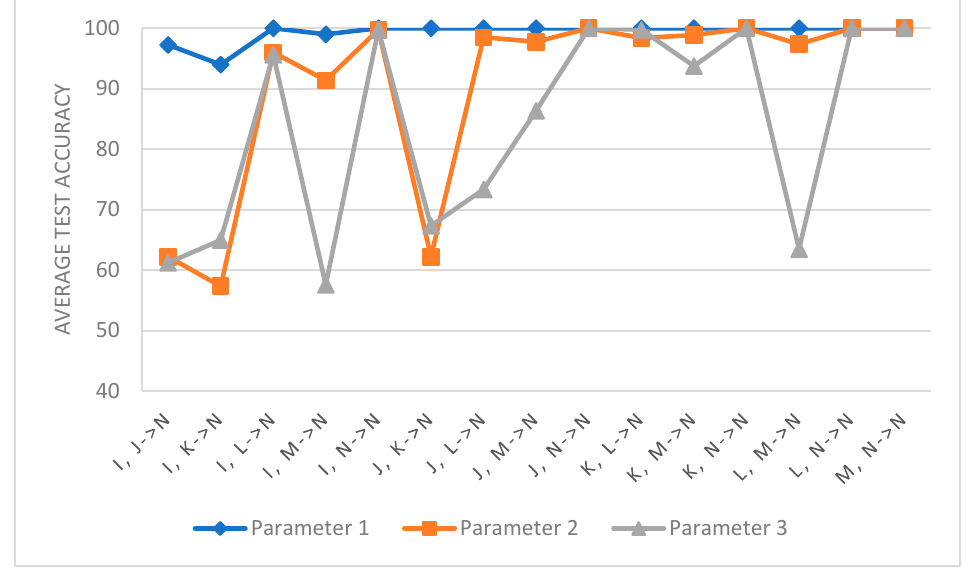
Table 6. Different parameter settings on the MFPT data set.